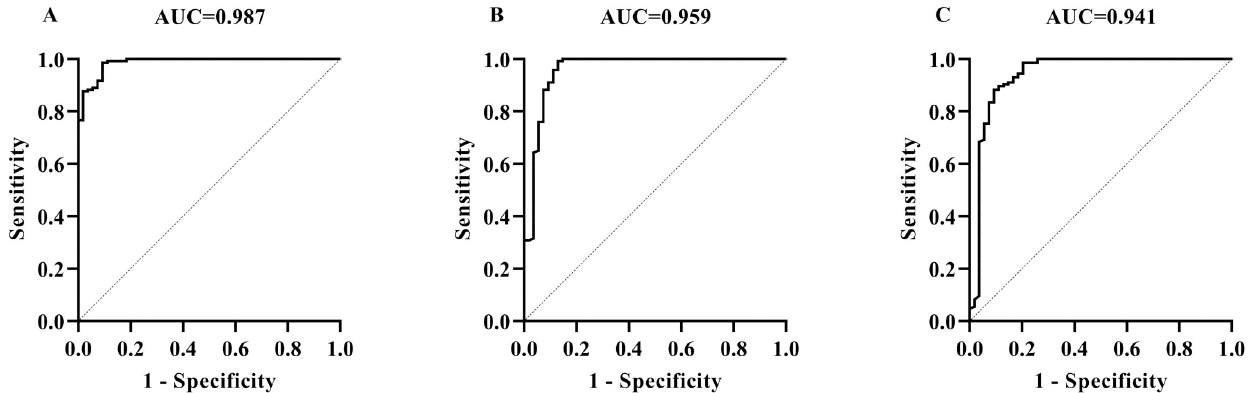
Fig 5. Determination of cut-off values, diagnostic sensitivities, and specificities of MMEC/AG-iELISA for cervid TB caused by M . bovis or M . caprae infection by using the maximum AUC. The ROC curves of MMEC/AG-iELISA for detecting antibodies in serum samples at dilutions of 1:25 (A), 1:50 (B), and 1:100